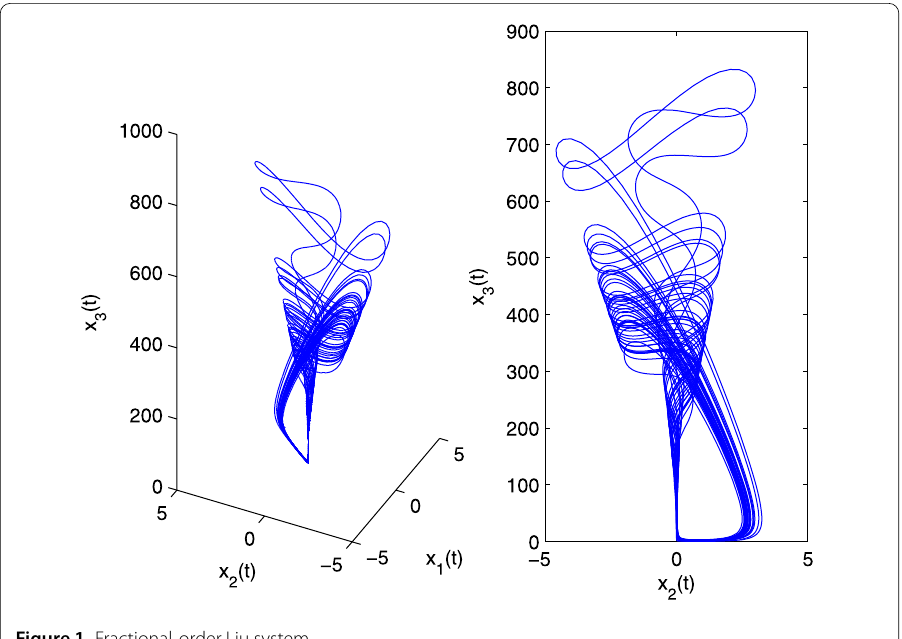
Figure 1 Fractional-order Liu